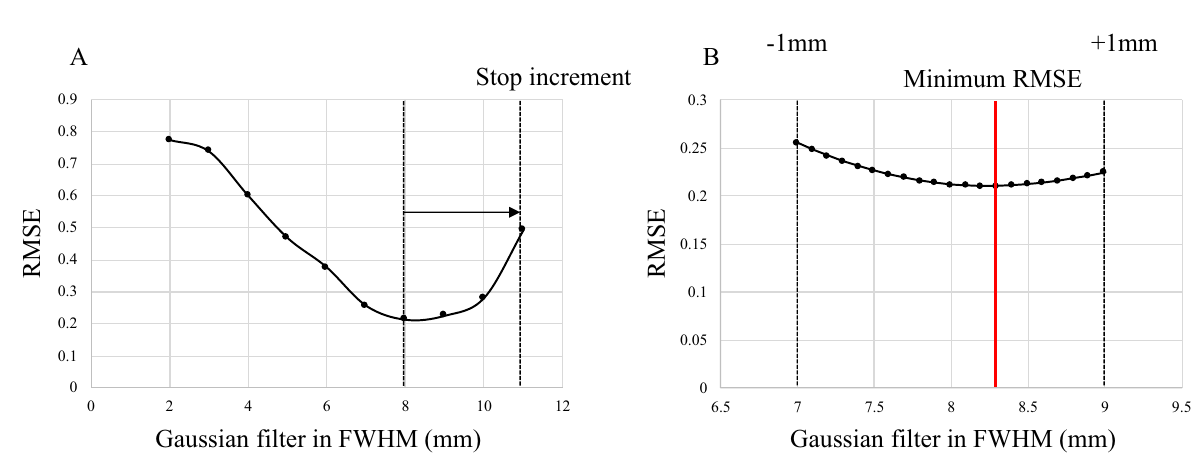
Figure 2. Optimization strategy used by the RC Tool for